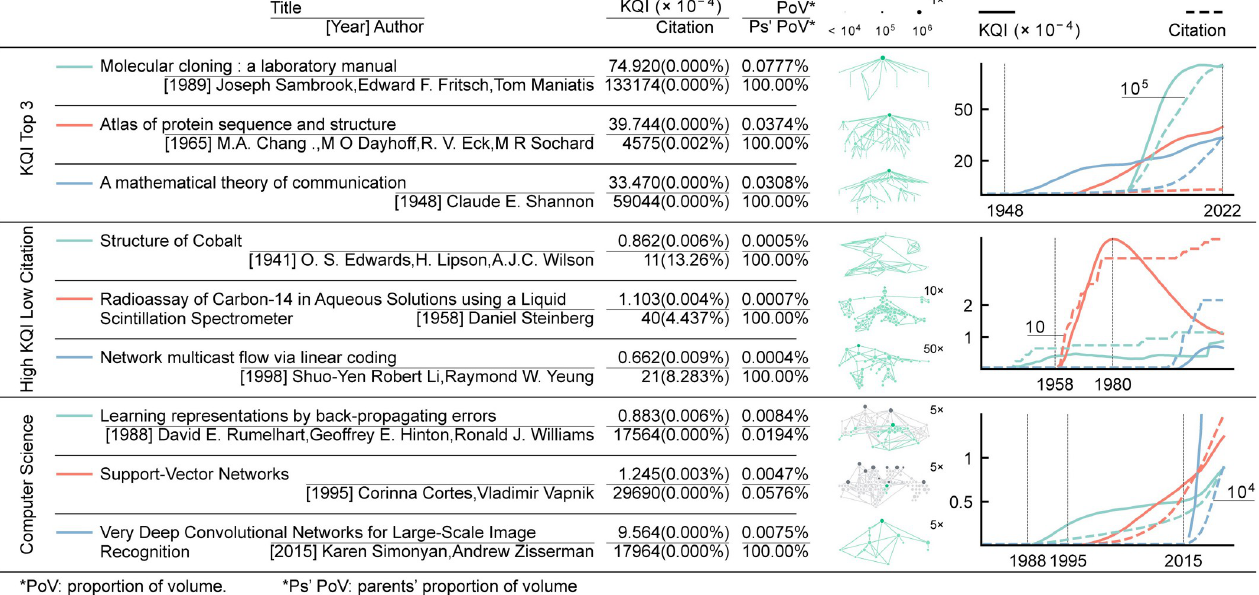
Fig 2. KQI, citation, volume, and visualization of typical literature. Three categories, overall KQI top 3, high KQI low citation, and computer science field, each containing three papers, are listed with KQI (ranking percentage), citation (ranking percentage), the proportion of volume, and parents’ proportion of volume. The position of each paper P in the citation network is also visualized, where the dark green node is the paper P itself, the light green nodes are inherited from P, the dark gray nodes are referenced by P, and the light gray nodes are inherited from these references. The size of the nodes indicates the volume, and the pictures where the volume of child nodes is small are enlarged by 5x, 10x, and 50x to show more details. The trends in KQI (solid) and citations (dashed) are also plotted over time, from the publication of the paper to the present.